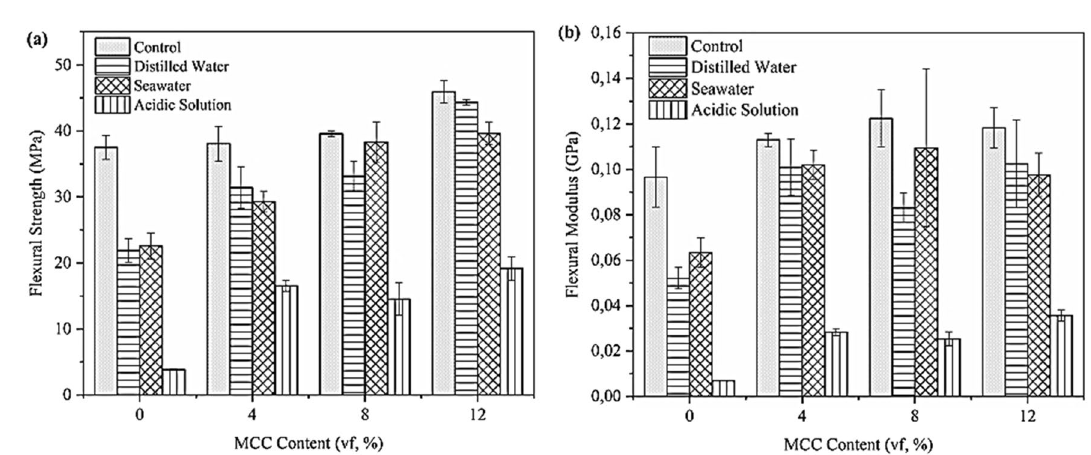
Figure 16. Plot curve of the ( a ) flexural strength and ( b ) flexural modulus of the